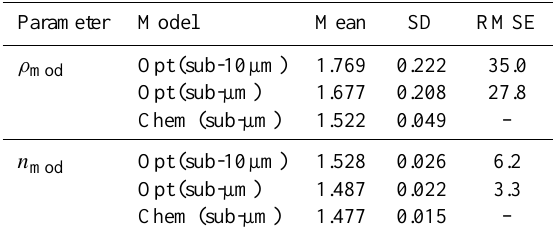
Table 2b. The same as Table 2a but for retrievals under dry condi- tions (104 points; RH = 53.7 ± 4.2).